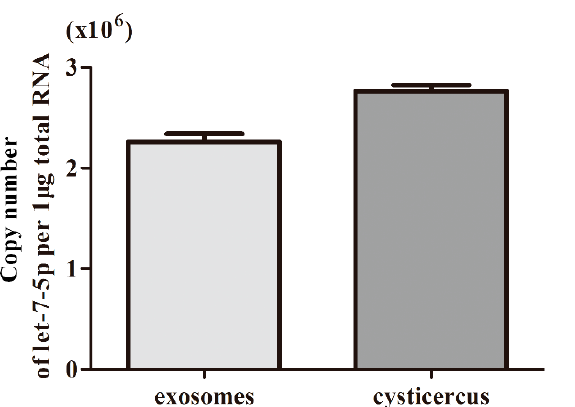
Figure 2. The copy number of miR-let-7-5p in exosome-like vesicles and cysticercus of T. pisiformis . Data were from 3 independent experiments.